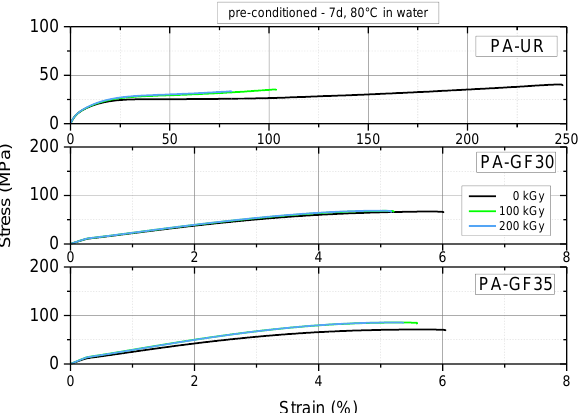
Figure 10. Tensile stress – strain curves for three PA grades in the water saturated condition at 23 °C depicting the effect of irradiation dose.